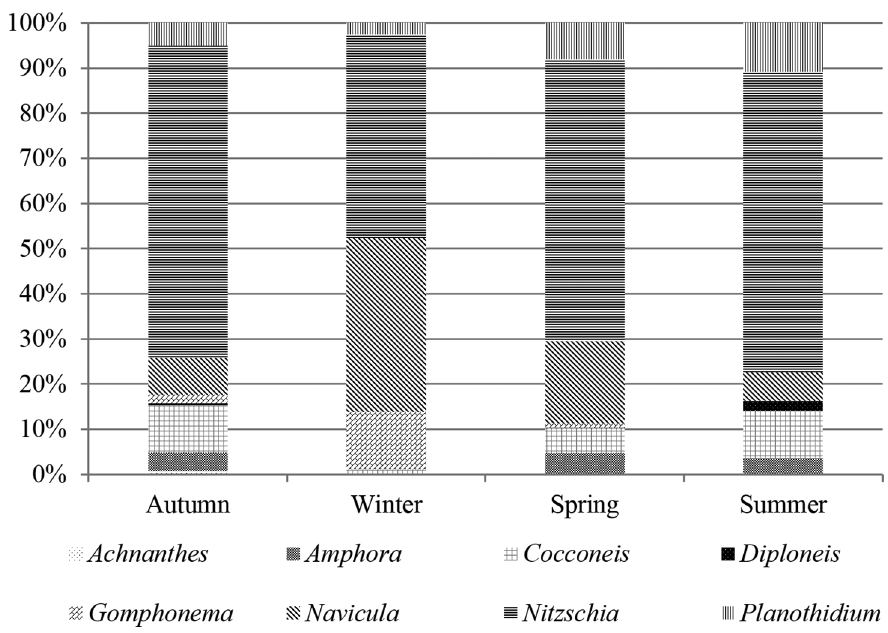
Figure 2. Relative distribution of the genus that accounts for at least three species of epiphytic diatoms in A. danaeifolium the period of May 2011 to January 2012 (total number of valves